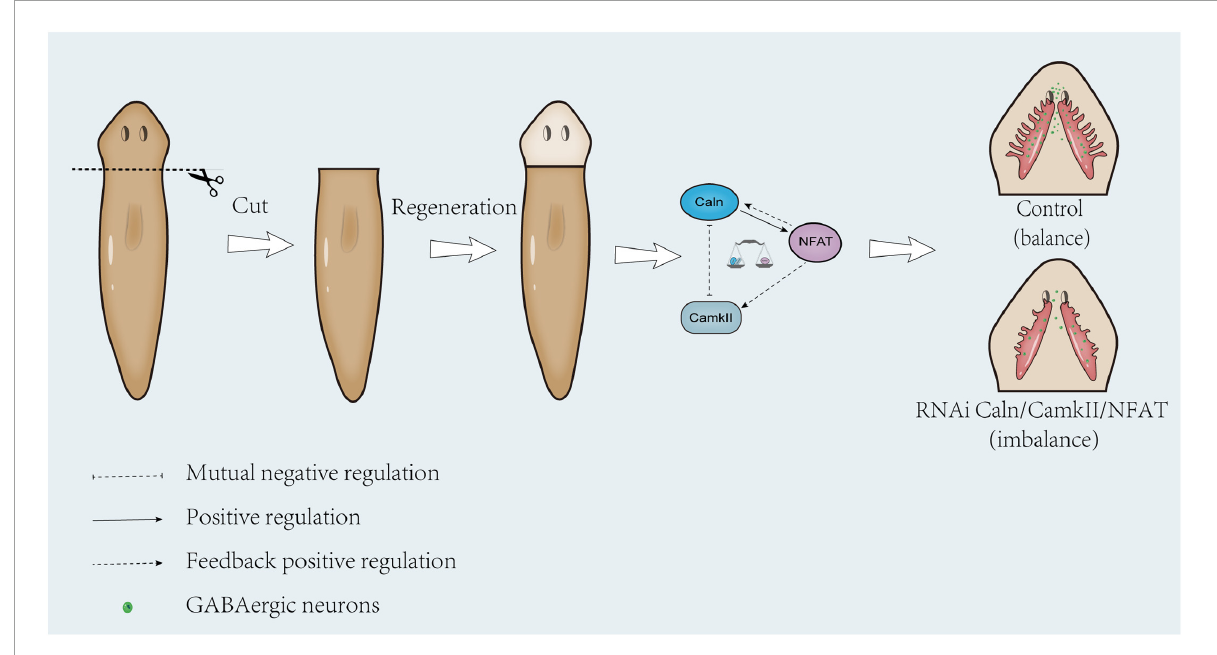
FIGURE8 Proposed model illustrating feedback loop between DjCaln , DjCamkII, and DjNFAT that regulates the number of GABAergic neurons during planarian head regeneration. In the control group, the mutual regulation of DjCaln , DjCamkII , and DjNFAT was in balance, and the GABAergic neurons could be normal formed during the planarian head regeneration. In the absence of adequate regulation of DjCaln or DjCamkII after DjNFAT RNAi, the number of GABAergic neurons would be reduced during planarian head